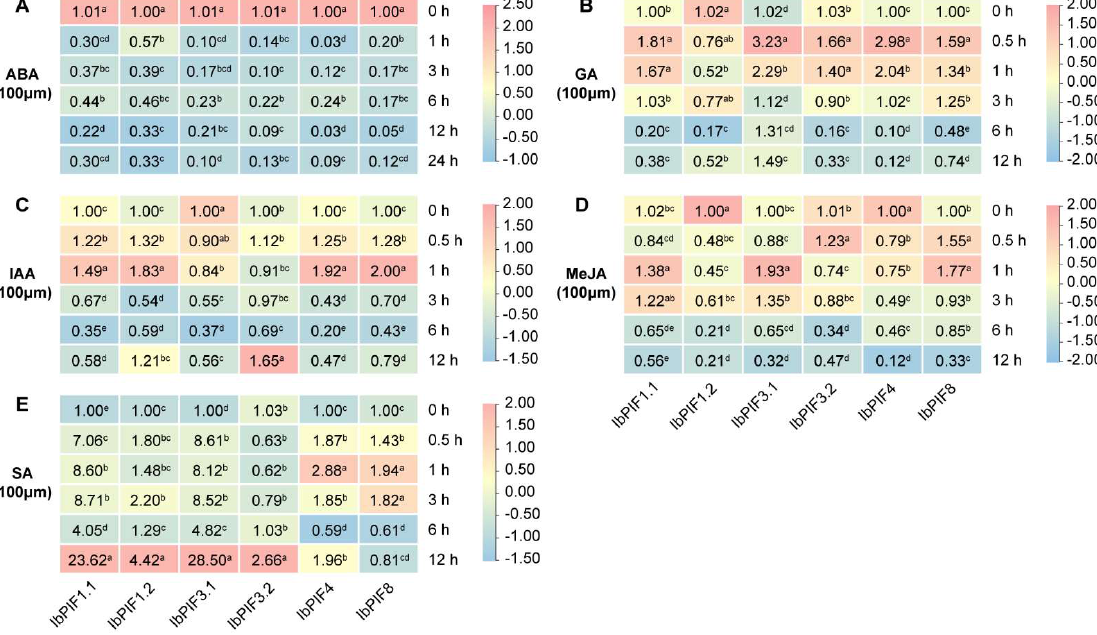
Figure 7. Gene expression patterns of IbPIFs in response to different phytohormones in I. batatas : ( A ) ABA; ( B ) GA; ( C ) IAA; ( D ) MeJA; and ( E ) SA. The values were determined by qRT-PCR from three